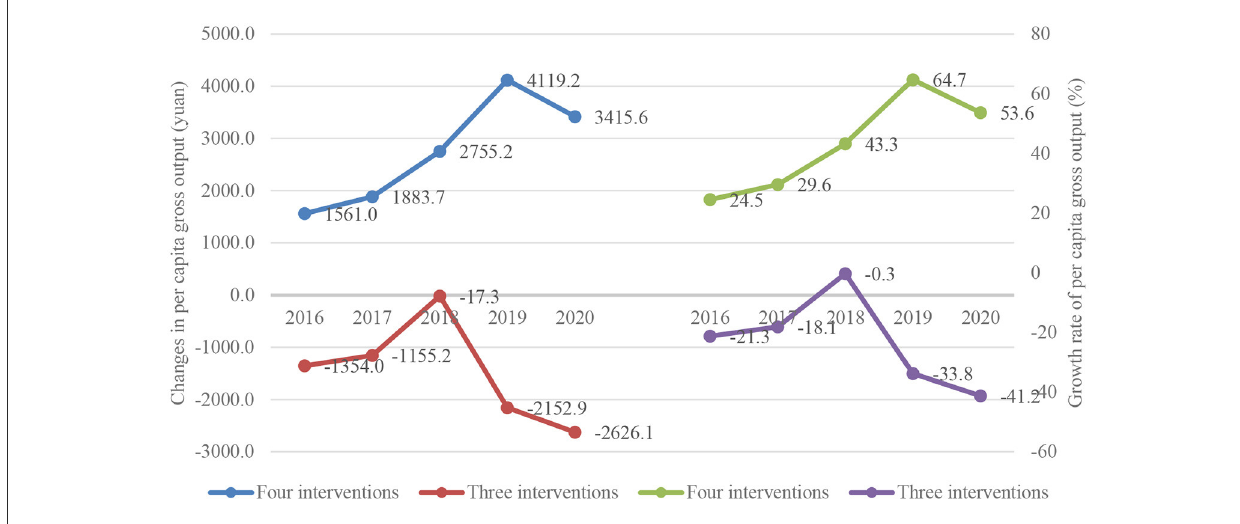
FIGURE2 Yearly changes in per capita gross output of animal husbandry (left) and its growth rate (right) in counties with all four measures and with three measures (no lamb vaccination).